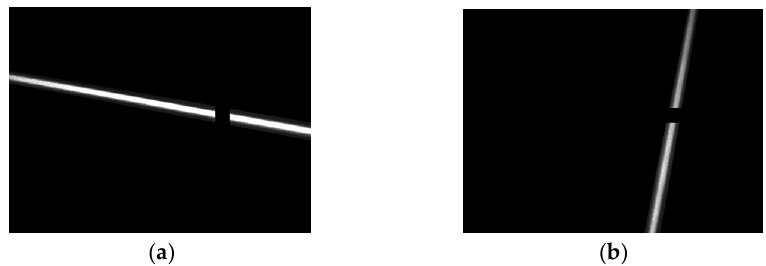
Figure 10. (a) Separation result of X axis line. (b) Separation result of Y axis line. Figure 10. ( a ) Separation result of X axis line. ( b ) Separation result of Y axis